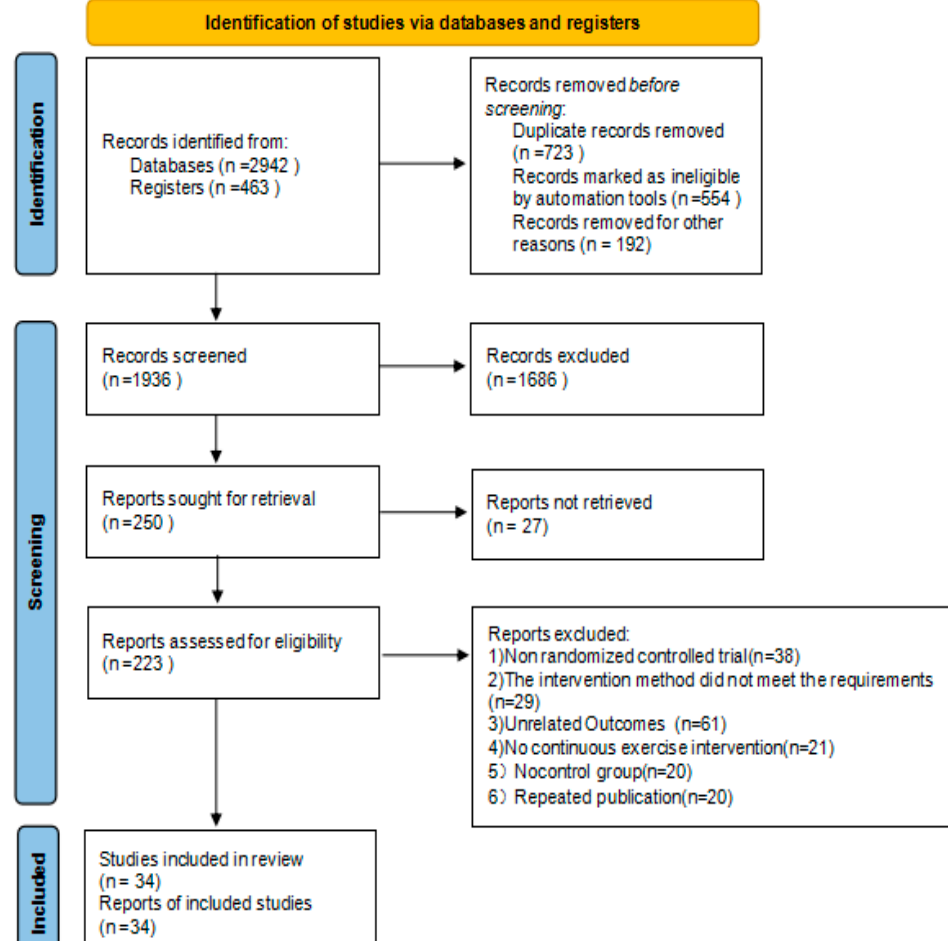
Figure 1. The flow diagram of the selection process.